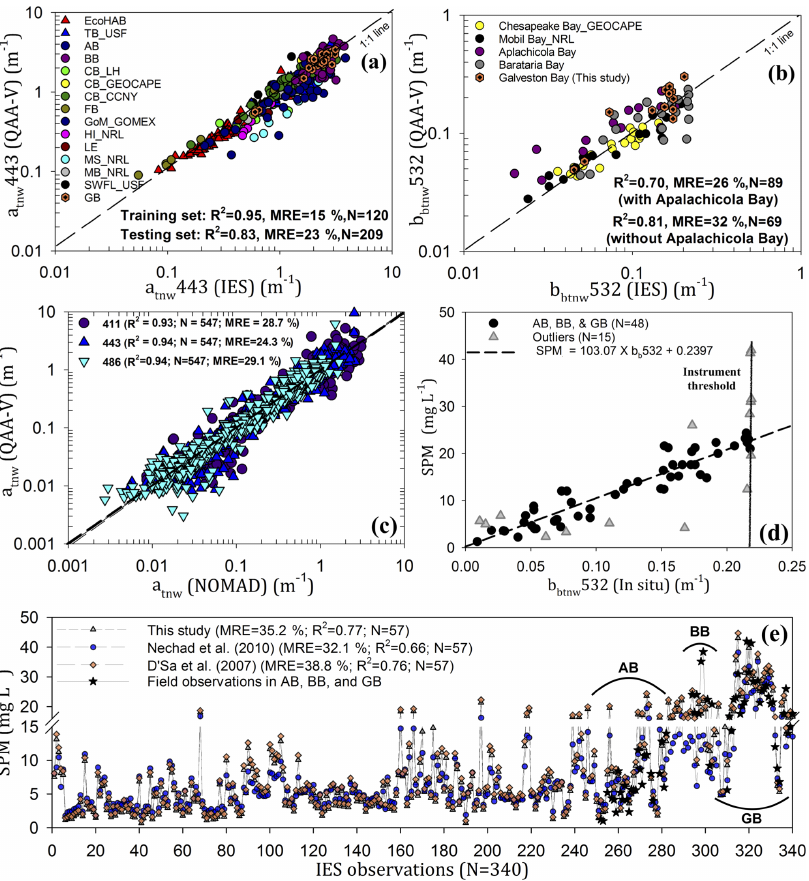
Figure 7. Evaluation of QAA-V’s performance on the estuarine and nearshore dataset (IES) for (a) a tnw 443 and (b) b btnw 532 and on the NOMADs for (c) a tnw at 411nm (dark blue), 443nm (blue), and 488nm (cyan) wavelengths. (d) SPM– b btnw 532 relationship ( R 2 = 0 . 89 without outliers) that was formulated based on field observations in Apalachicola Bay, Barataria Bay, and Galveston Bay. (e) A comparison of the SPM– b btnw 532 relationship in this study (grey triangles) with SPM models from Nechad et al. (2010; blue circles) and D’Sa et al. (2007; orange squares) and with field observations in AB, BB, and GB (black stars). TB: Tampa Bay, AB: Apalachicola Bay, BB: Barataria Bay, CB: Chesapeake Bay, FB: Florida Bay, GoM: Gulf of Mexico, HI: Horn Island, LE: Lake Erie, MS: Mississippi Sound, MB: Mobile Bay, SWFL: southwest Florida, GB: Galveston Bay (Table 1). Training set includes EcoHAB and Tampa Bay datasets. MRE: absolute mean relative error